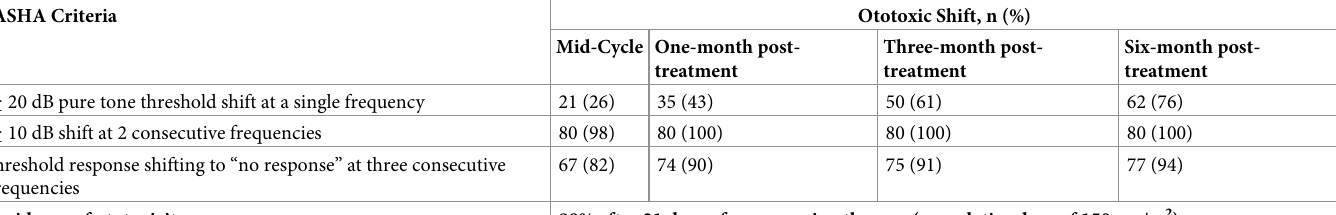
Table 4. Incidence of ototoxic shift according to ASHA criteria.